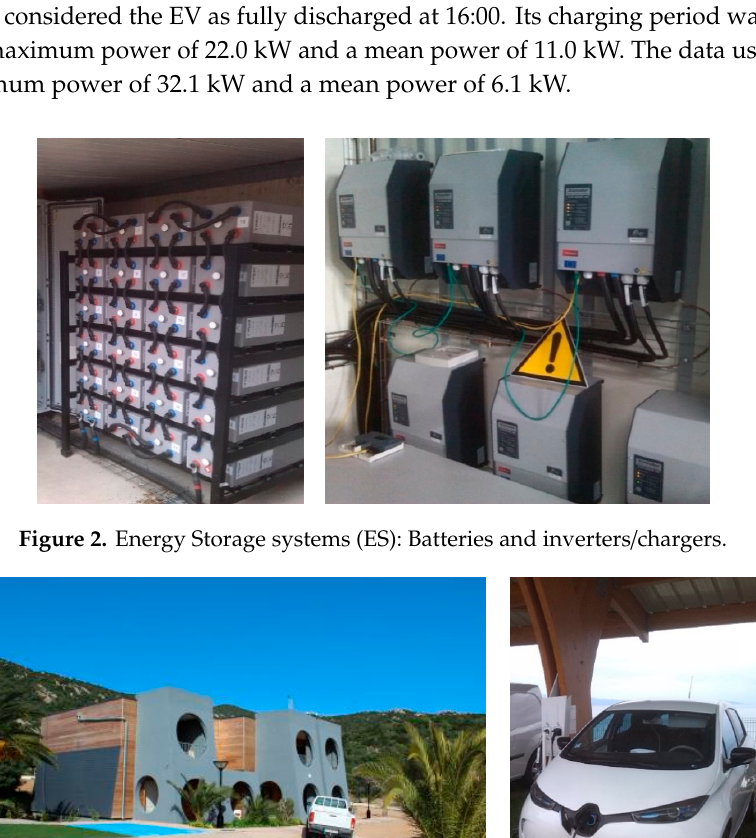
Figure 3. Loads: Accommodation and electric vehicle.